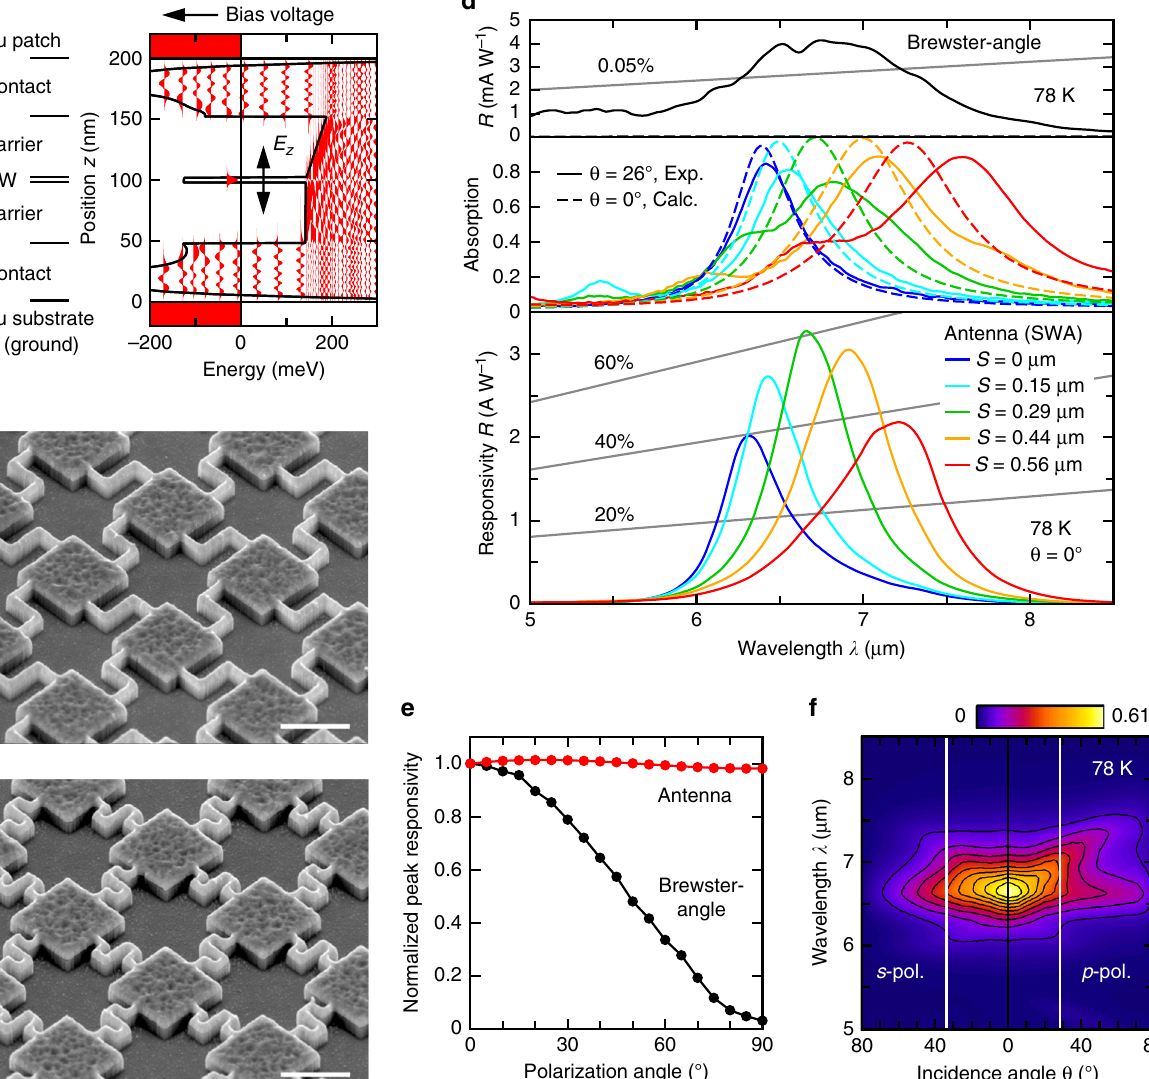
Fig. 2 Fabrication and characterization of wired-antenna-enhanced QWIPs. a QW design, and numerical conduction band pro fi le and wave functions based on experimental dopant density distribution. b Scanning electron micrograph of SWAs with Z-shaped ( S = 0.29 μ m) and c S-shaped ( S = 0.22 μ m) wires. Bar: 1 μ m. d Responsivity spectrum of the reference Brewster-angle detector (top), absorption spectra for Z-shaped SWAs with various S values measured for θ = 26°, s -polarized incidence (solid lines, middle) and calculated for θ = 0° (broken lines, middle), and the corresponding responsivity spectra for θ = 0° (bottom). Equief fi ciency ( η conv ) lines are also plotted. e , f Other properties for the detector with the maximum responsivity (Z-shaped, S = 0.29 μ m). e Polarization angle dependence of R p . Results for the Brewster-angle detector are also shown for reference. f Incidence-angle dependence of η p - (right) and s -polarization (left). Vertical lines denote the FOV/2 at half conv for